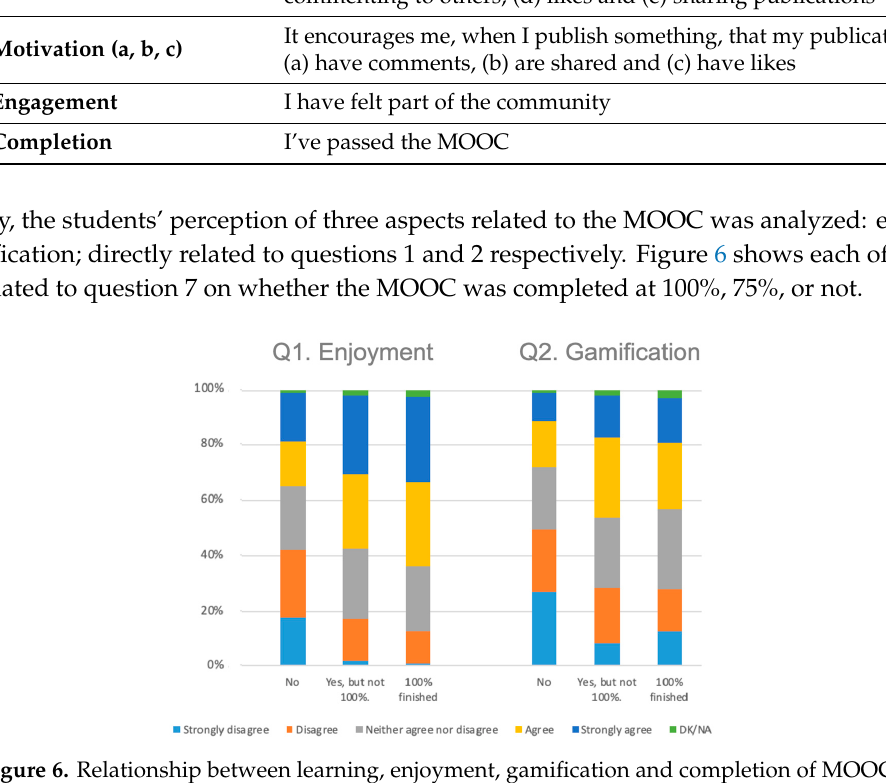
Table 4. Selected questions from the satisfaction survey for the study.